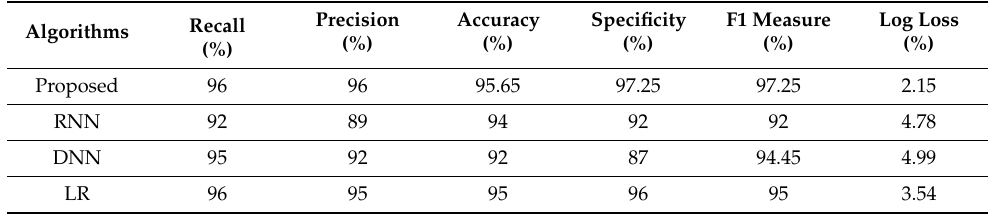
Table 3. Attack Classification Analysis: Man-in-the-Middle Attack.